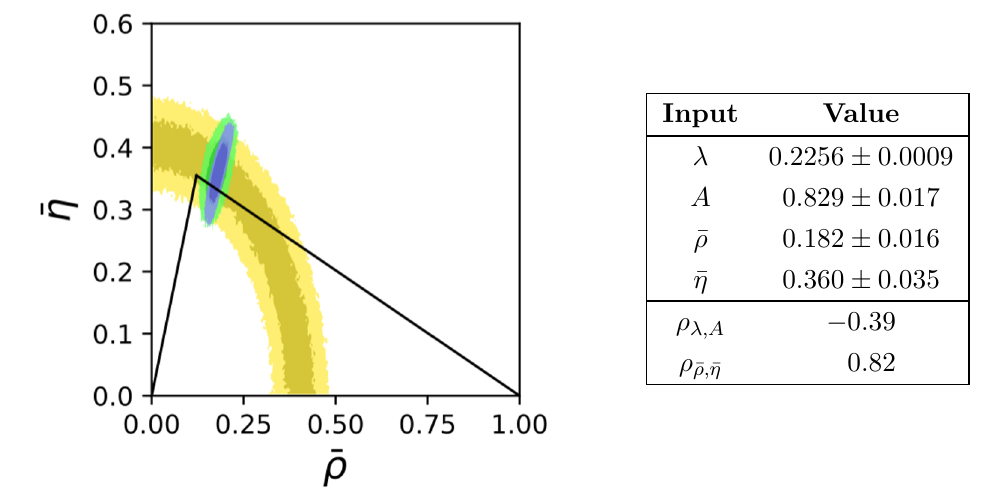
Figure 1 & Table 3. Results of the CKM fit. Fitting only tree-level observables, gives the allowed regions in yellow. The green regions include ∆ M B and ∆ M B as separate observables, and the blue s d regions the ratio V td /V ts from HFLAV [75] used for our fits. Darker and light colours correspond to 68% and 95.5% probability, respectively. The apex of the black triangle is the best fit point from the SM CKM fit to all observables [74]. The numerical values corresponding to the blue region are given in table 2. ρ i,j denote the correlations between the two parameters i and j